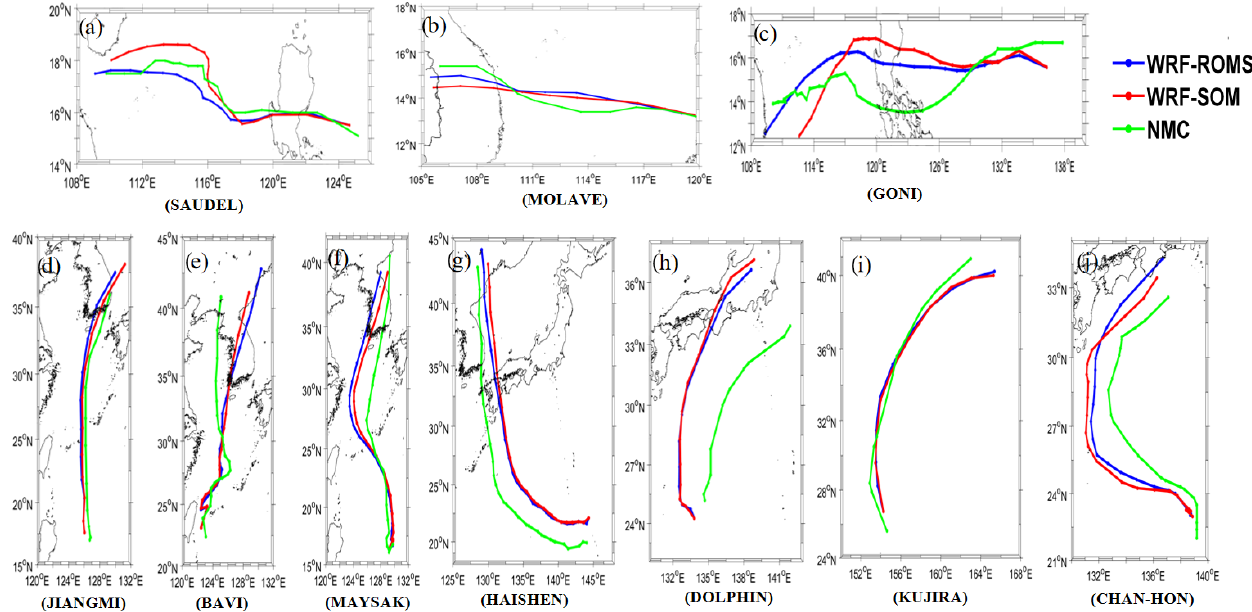
Figure 9. The typhoon tracks simulated in the WRF-SOM (red) and WRF-ROMS (blue) compared with National Meteorological Center (NMC) (green) during typhoon season (NMC data, http://typhoon.nmc.cn/web.html, last access: 27 January 2023).